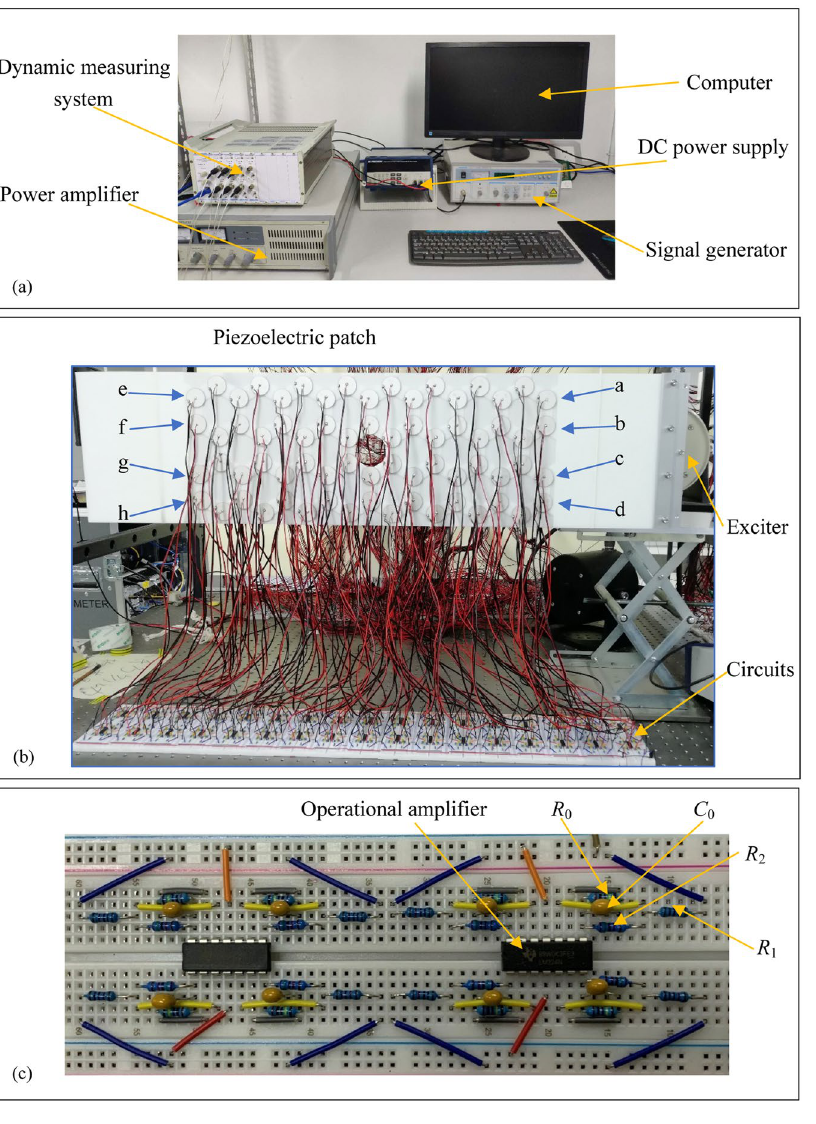
Figure 4. Experimental setup: ( a ) The testing system, ( b ) the whole structure with the active control system and ( c ) the negative capacitance circuit.